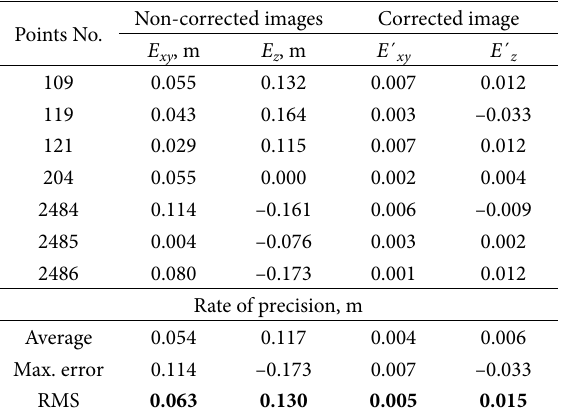
Table 5. Deviation of stereo-digitalization points